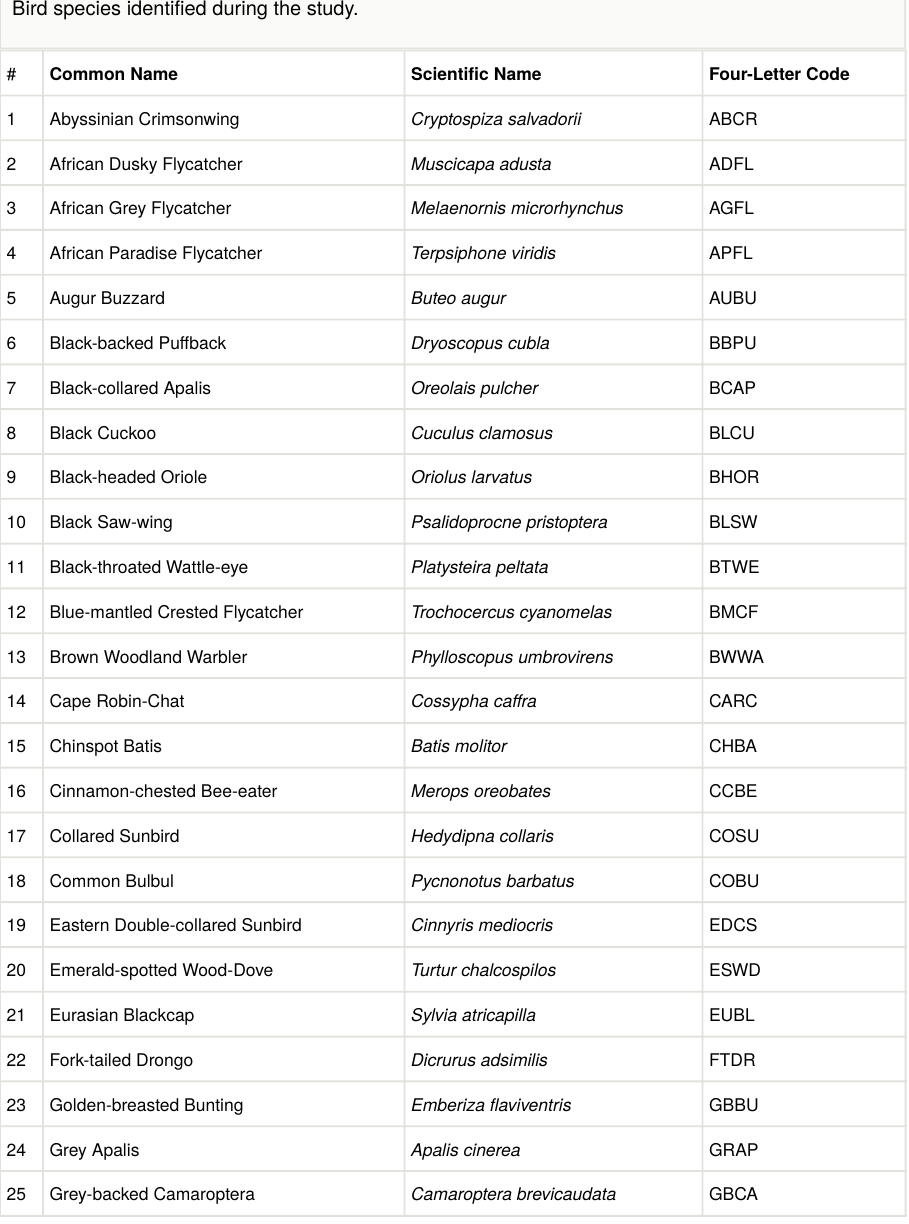
Table 1. Bird species identi fi ed during